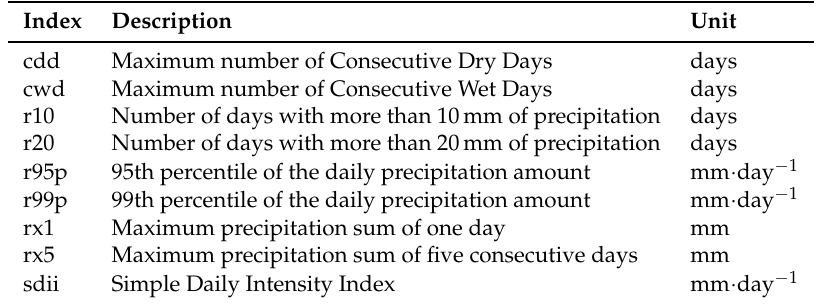
Table 1. List of used Expert Team on Climate Change and Detection precipitation indices